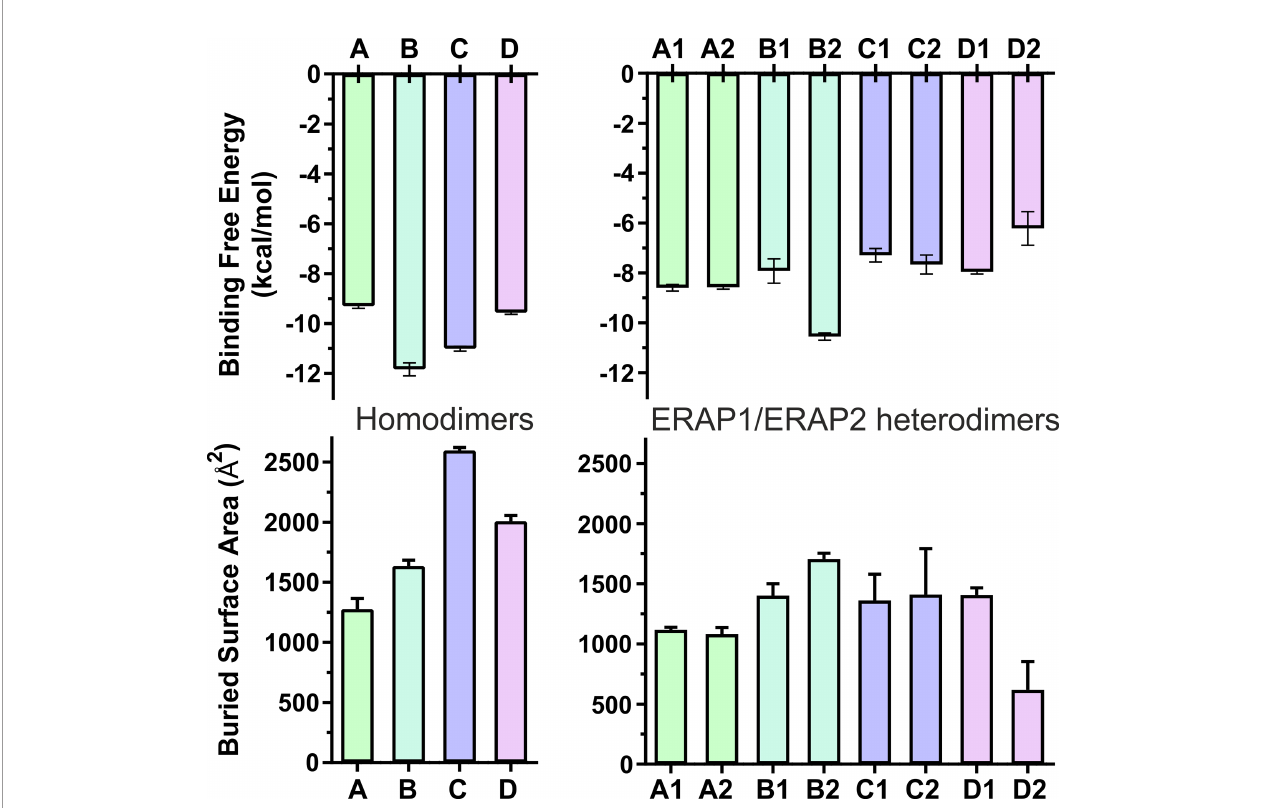
FIGURE 3 | Bar plots of the estimated binding af fi nity ( D G est , upper panels) and the buried surface area (BSA, lower panels) for each crystallographic homodimer (left panels) and the corresponding heterodimeric models of ERAP1/ERAP2 (right panels). Mean values were calculated from 3 independent 100-ns MD simulations, and error bars indicate standard